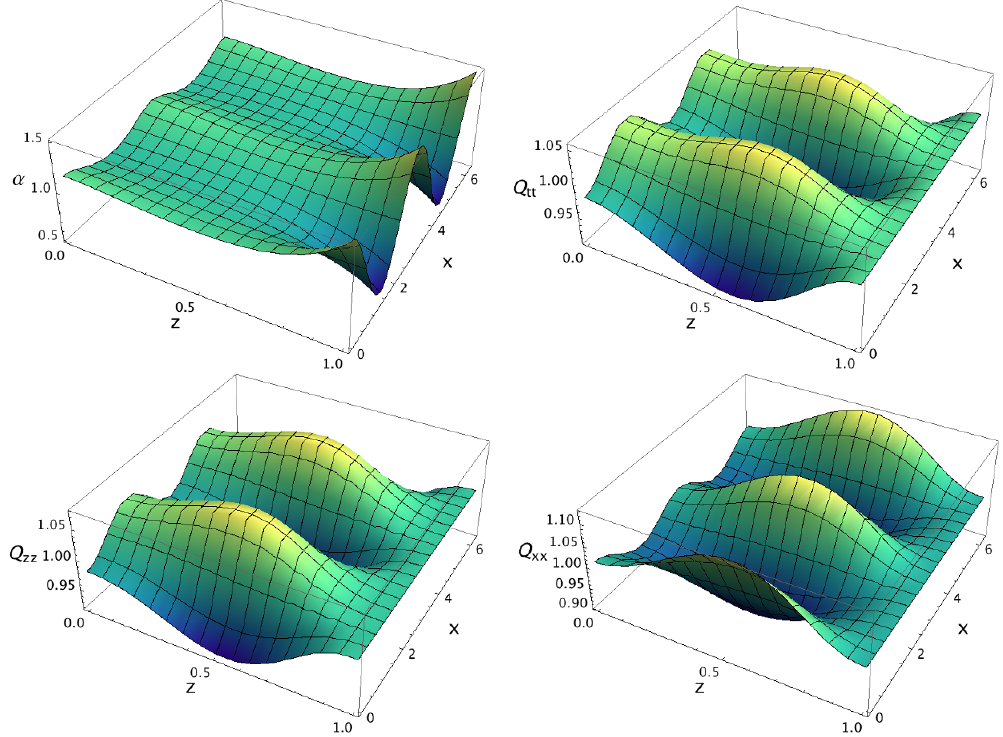
Figure 2 . Background con(cid:12)gurations for the gauge (cid:12)eld (cid:11) and metric (cid:12)elds Q tt ; Q zz ; Q xx at T = 0 : 01426 and k = 1, for the PDW phase with the ionic lattice (cid:22) ( x ) = 1 + 0 : 5 cos(2 x ). The horizon is located at z = 0 while the AdS boundary at z = 1. We have set L = 1 =